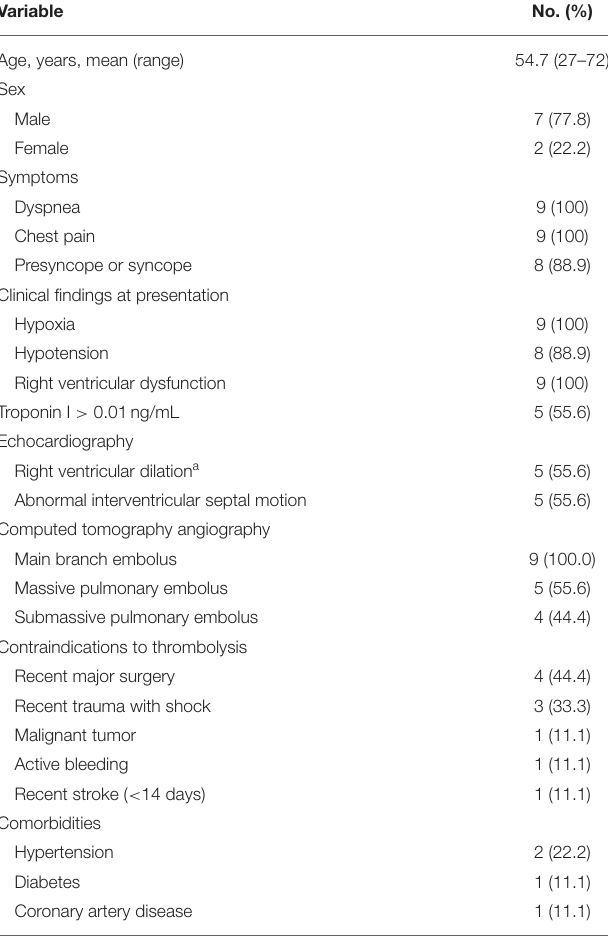
TABLE 1 | Baseline demographics, clinical characteristics, and thrombolysis contraindications of all treated patients. Variable